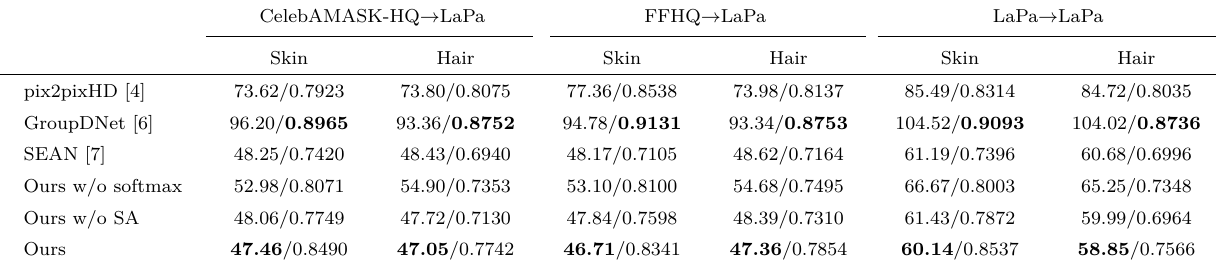
Table 3 PSNR ↓ and HS ↑ results for cross-dataset regional style transfer. Although pix2pixHD and GroupDNet have better HS than our method, these two methods achieve harmony at the expense of severely modifying other regions (see Fig. 7), contradicting the goals of